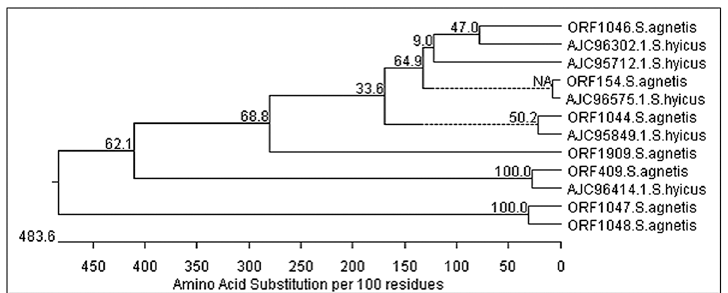
Fig 4. Phylogenetic tree of fibronectin binding proteins from S . agnetis with homologs from S . hyicus . The protein sequences predicted for the seven ORFs from S . agnetis (see text) were aligned using Clustal W to the five predicted fibronectin proteins for the S . hyicus ATCC11294 genome (AJC entries are accession numbers) representing the closest orthologs in NCBI for the proteins from S . agnetis . The phylogenetic tree includes bootstrap significance for 2500